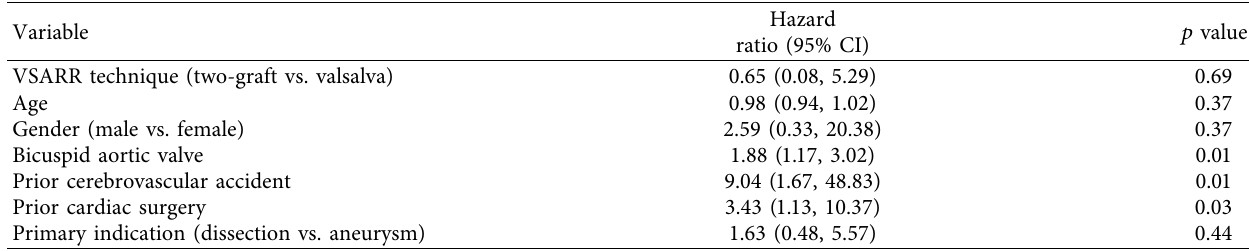
Figure 2: Kaplan–Meier long-term survival of valve-sparing aortic root replacement patients who underwent the David-V-Valsalva graft (5- year: 96%) or David-V-Smod (5-year: 100%) techniques. Table 4: Cox proportional hazards regression for the risk factors of long-term